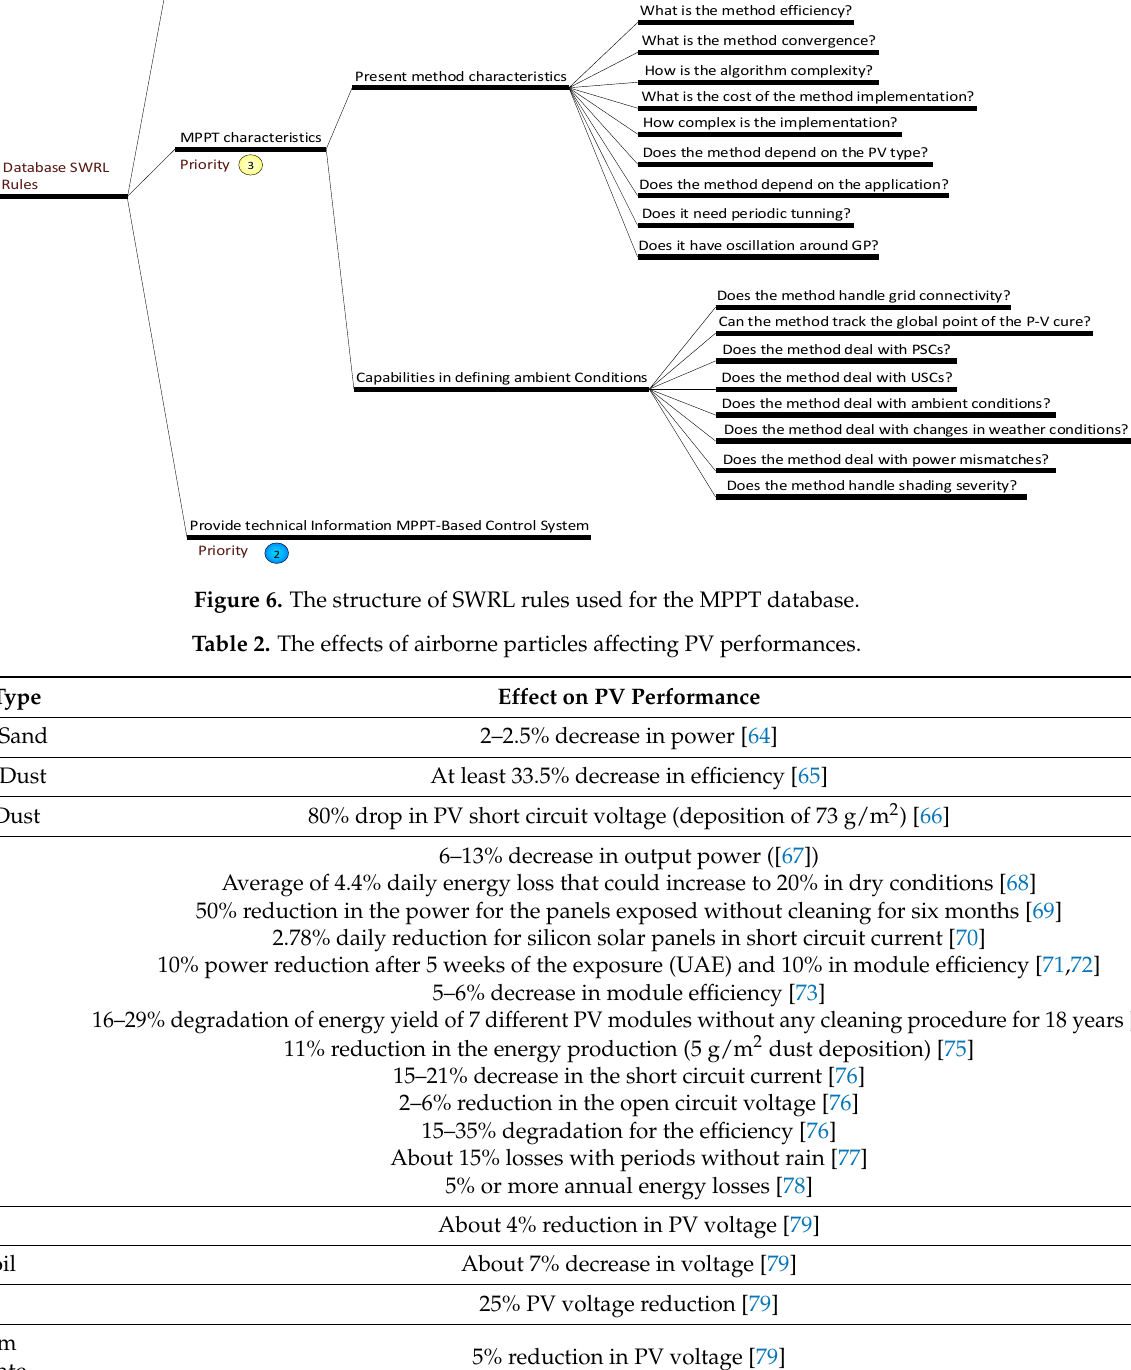
Table 2. The effects of airborne particles affecting PV performances.